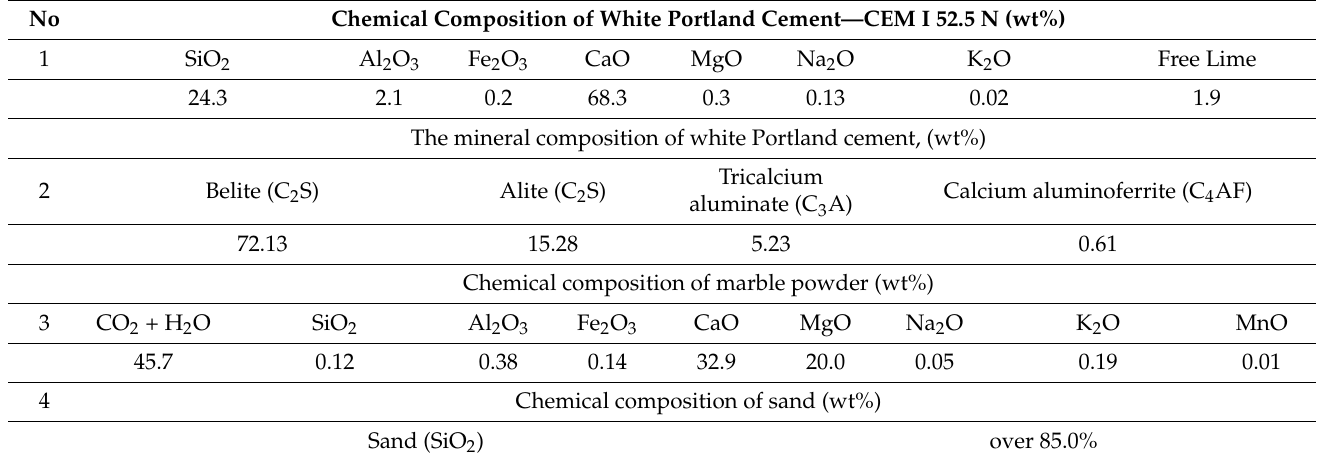
Table 1. Chemical and mineral composition of white Portland cement and used aggregates.